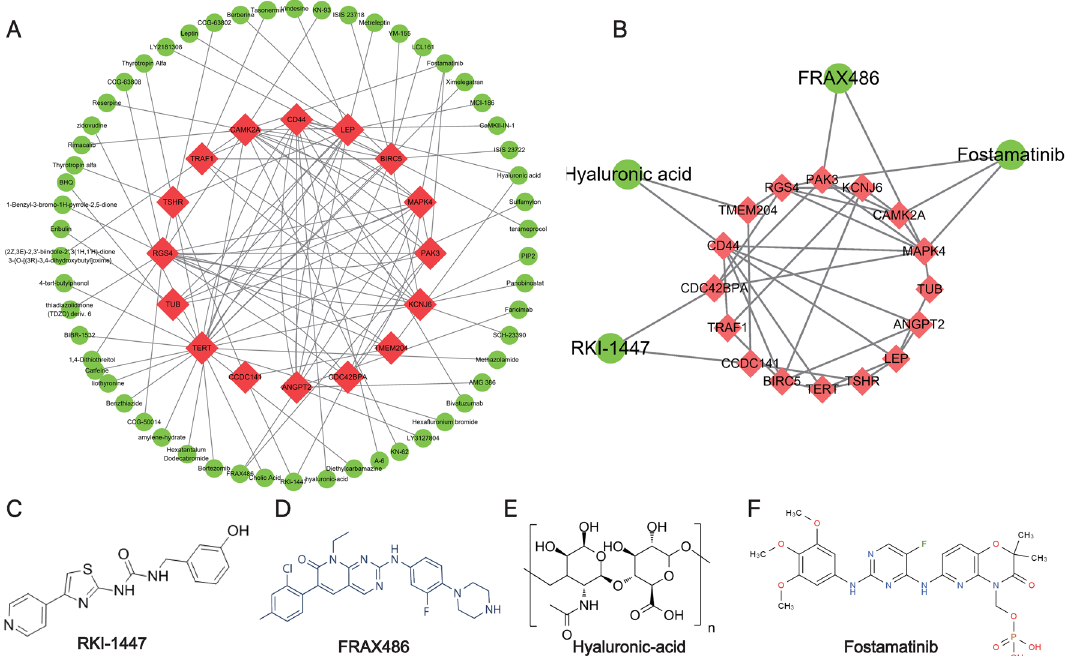
Figure 10. Identification of potential drugs and construction of drug-target gene interaction network and sub- network. ( A ) Drug-target gene interaction network. ( B ) Sub-network. The green circles represent the candidate drugs and the red rhombuses represent the proteins encoded by target genes. ( C ) Molecular structure of RKI- 1447. ( D ) Molecular structure of FRAX486. ( E ) Molecular structure of Hyaluronic acid. ( F ) Molecular structure of